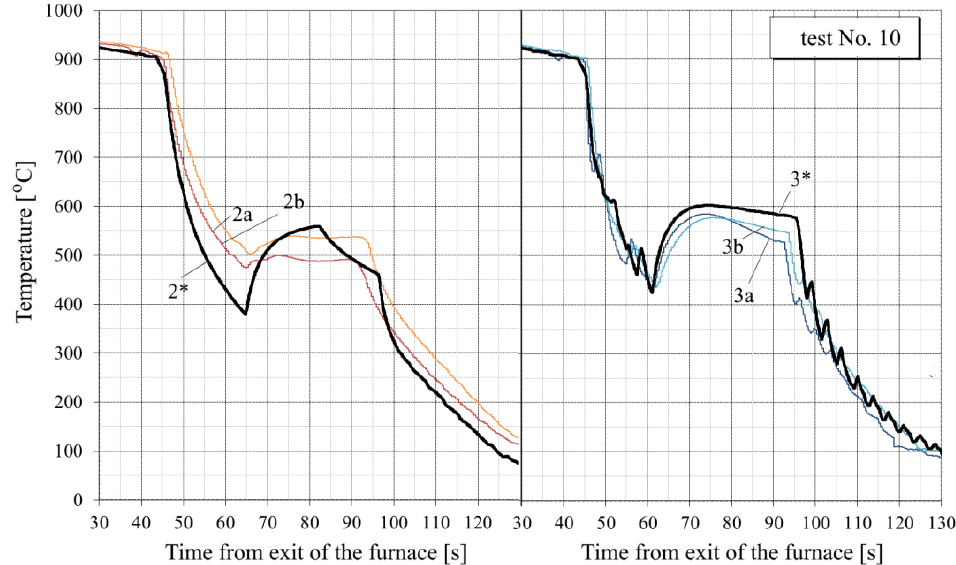
Figure 16. Graphs of cooling in test No. 10. Numbers without an asterisk denote experimental curves according to the thermocouple data: 2a — at the top in the middle of the width; 2b — at the top at the edge; 3a — at the bottom in the middle of the width; 3b — at the bottom at the edge. Numbers with one asterisk indicate calculated curves for the corresponding control points across the thickness of the plate: 2* — at a depth of 3 mm from the top surface; 3* — at a depth of 2.5 mm from the bottom surface. The analysis of the data obtained shows the